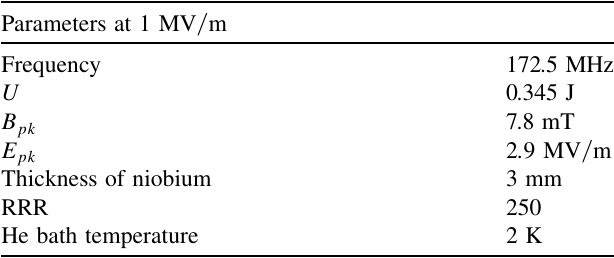
TABLE I. Parameters of the ANL half wave